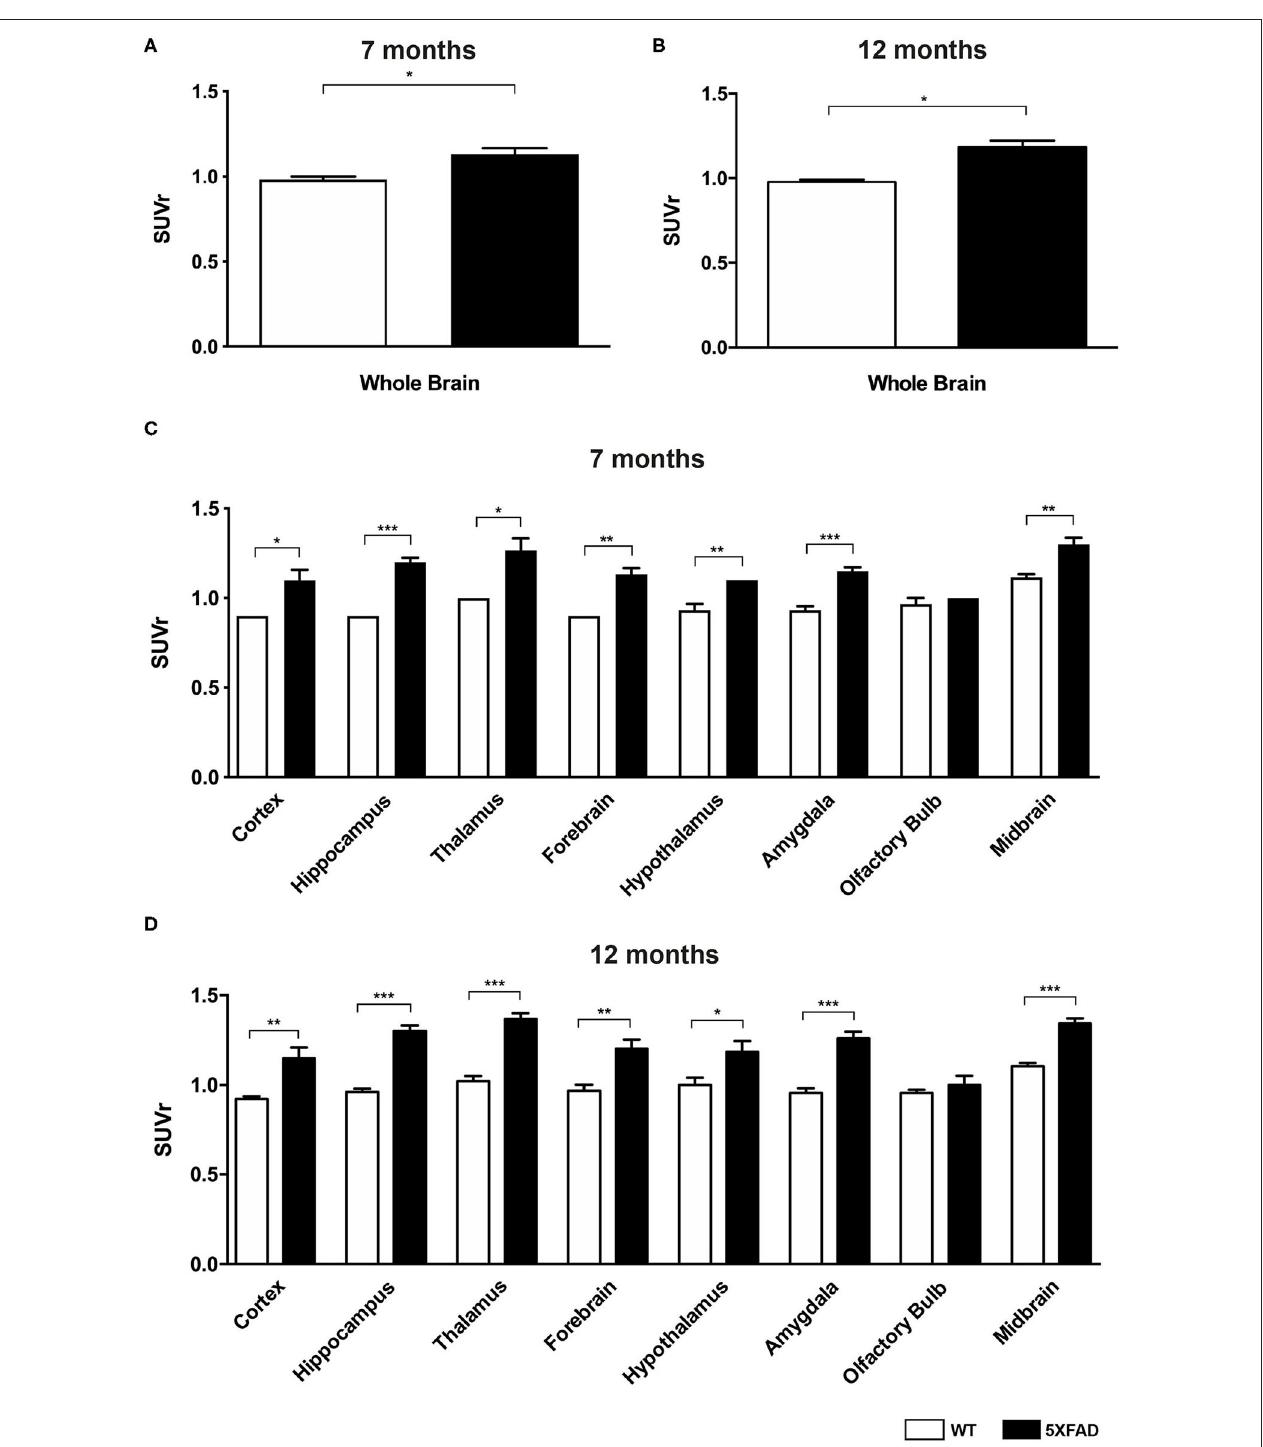
FIGURE 3 | 18 F-Florbetaben uptake in 7-and 12-month-old WT and 5XFAD mice. (A) 7-month-old 5XFAD mice showed a significantly higher SUVr in the whole brain compared to age-matched WT mice. (B) 12-month-old 5XFAD mice showed significantly higher SUVr in the whole brain compared to age-matched WT mice. (C) 7-month-old 5XFAD mice showed a significantly higher SUVr in all tested brain regions compared to age-matched WT mice except for the olfactory bulb region. (D) Significant differences in 12-month-old mice were also detected in all analyzed brain regions except for the olfactory bulb. Unpaired t -test; * p < 0.05; ** p < 0.01; *** p < 0.0001; data presented as mean + /-